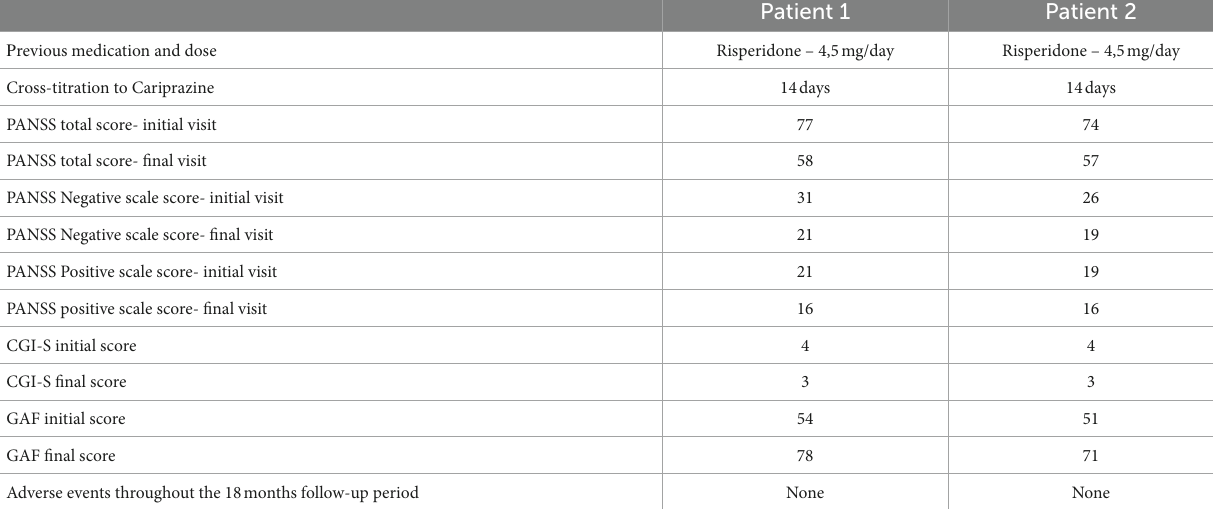
Patient 1 Patient